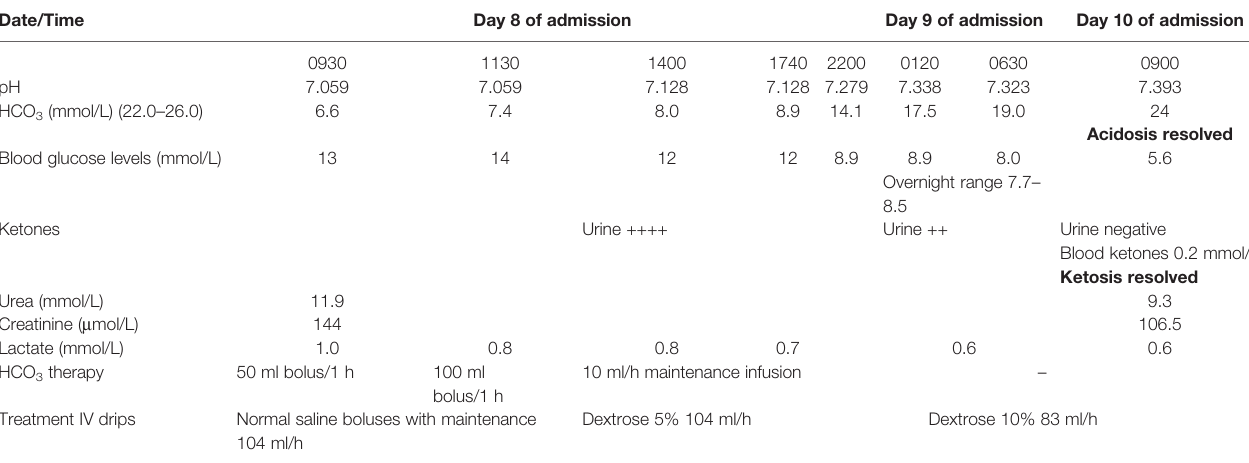
TABLE 1 | Serial blood investigation results and treatment